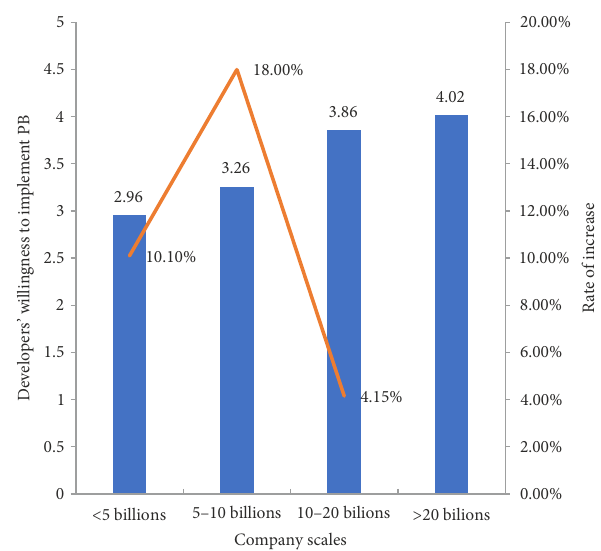
Figure 2. Company scales and developer’s willingness to implement PB Table 13. One-way analysis of variance of demand-side policy Measurement